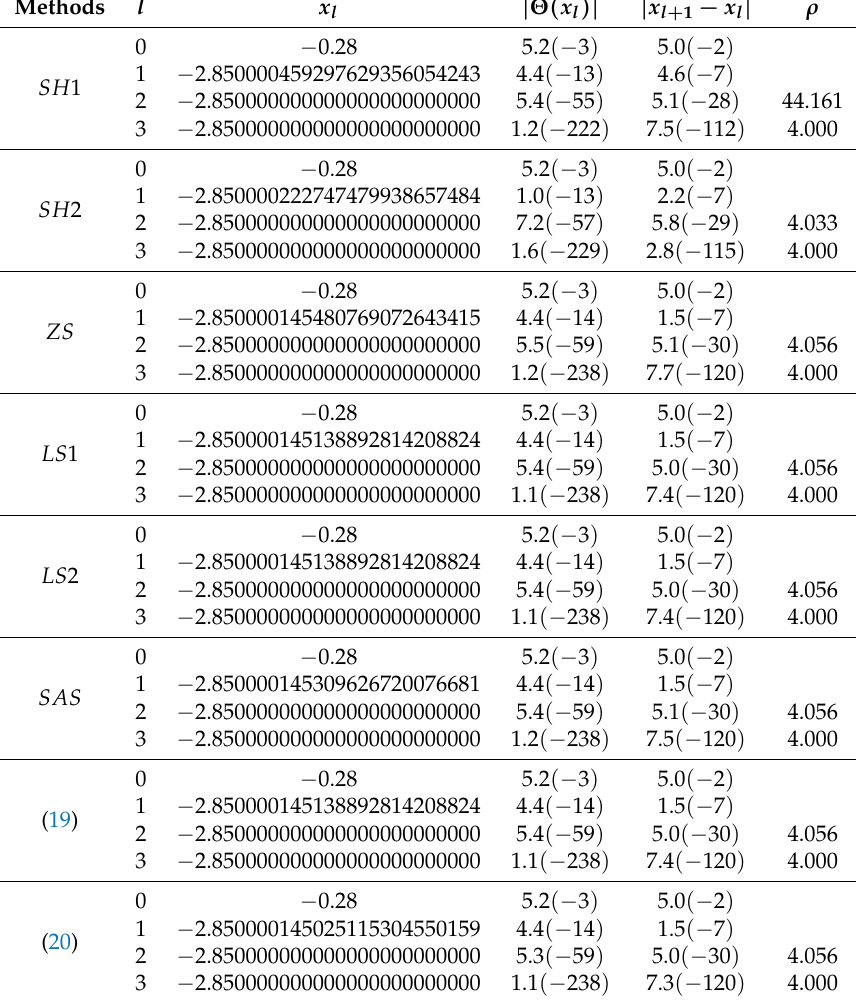
Table 4. Convergence study of distinct iterative functions on Θ 4 ( x )